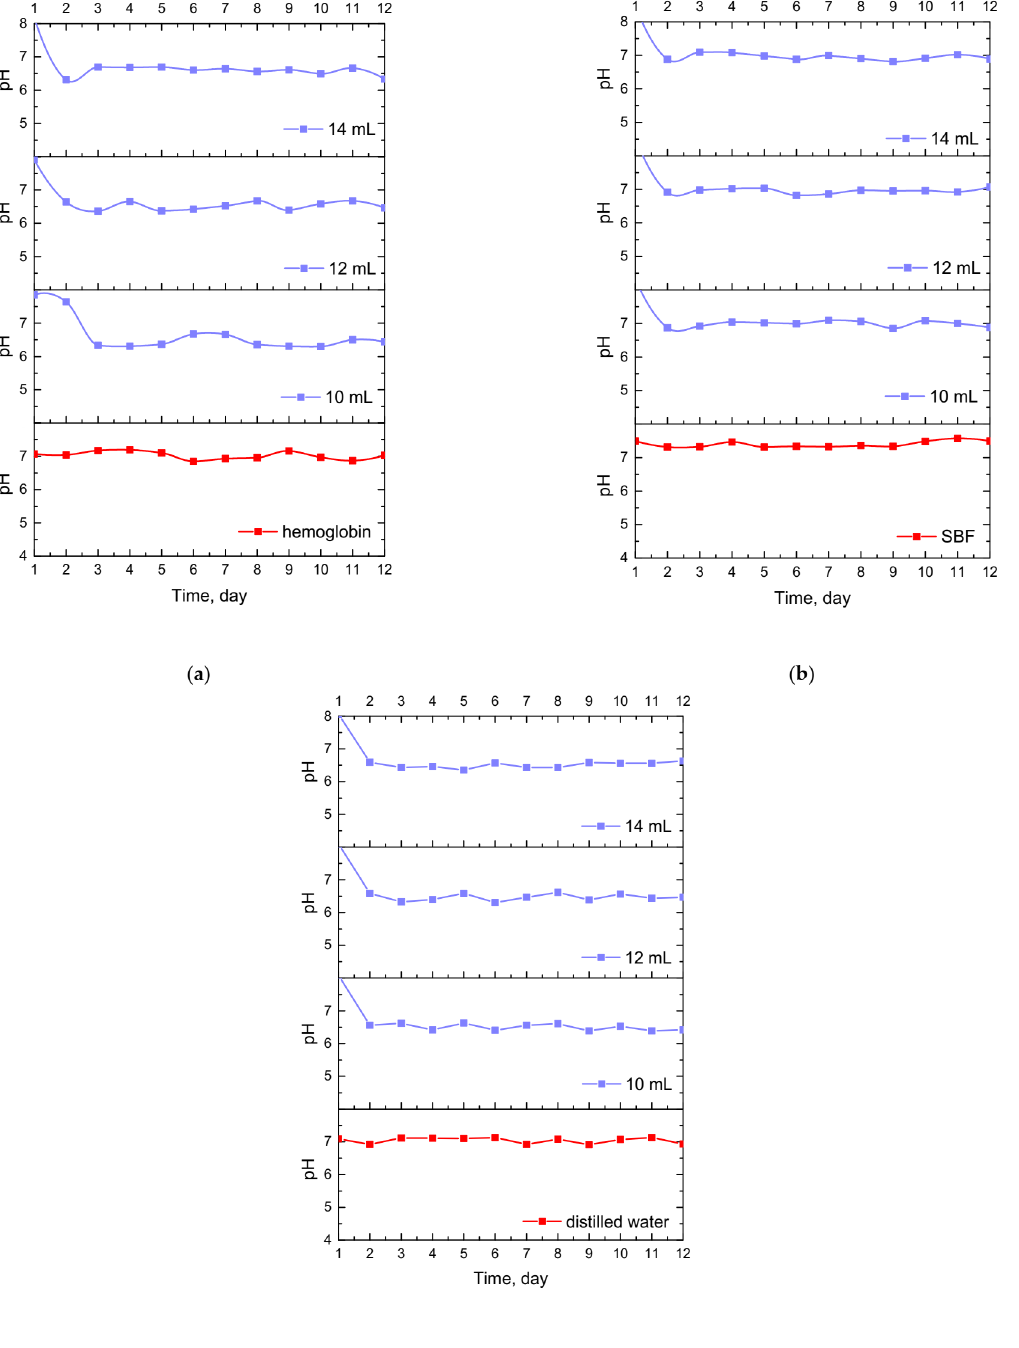
Figure 7. Changes in pH values determined during incubation of hydrogels modified with Equisetum arvense L. extract in hemoglobin ( a ), SBF ( b ) and distilled water ( c